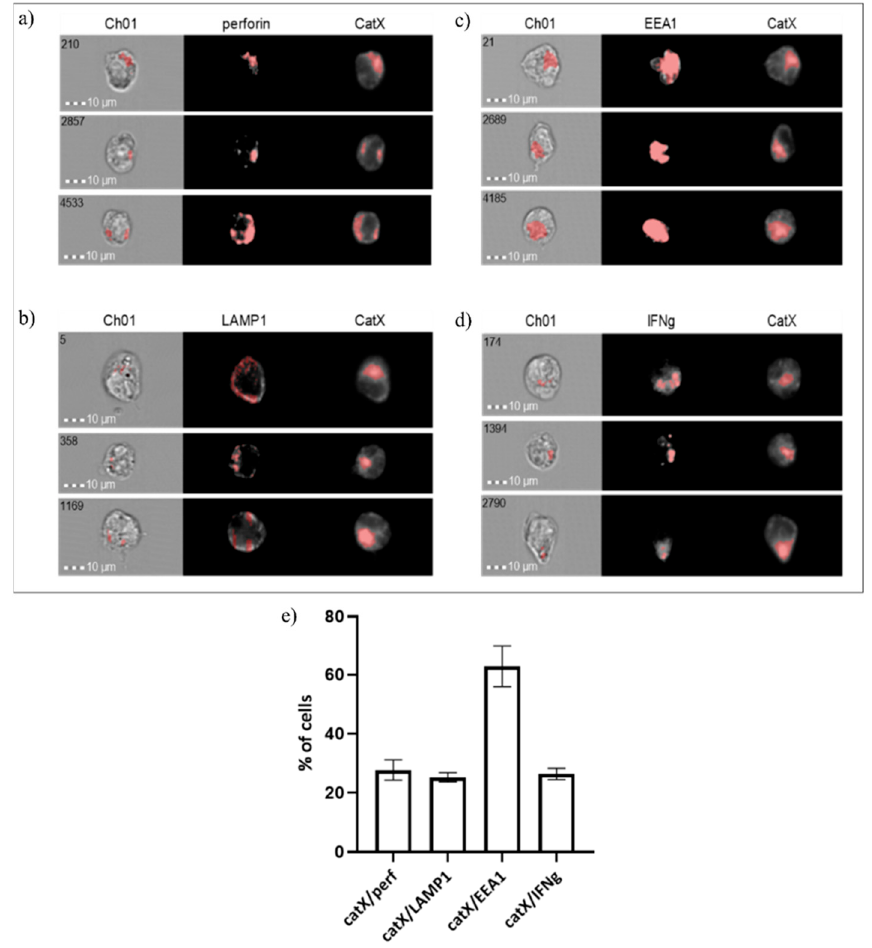
Figure 5. Co-localization of cathepsin X with cytotoxic granule marker perforin ( a ), lysosomal marker LAMP1 ( b ), endosomal marker EEA1 ( c ) and cytokine IFN γ ( d ) in NK-92 cells. The images are representative of the two independent experiments. ( e ) % of cells with cathepsin X co-localiza- tion.